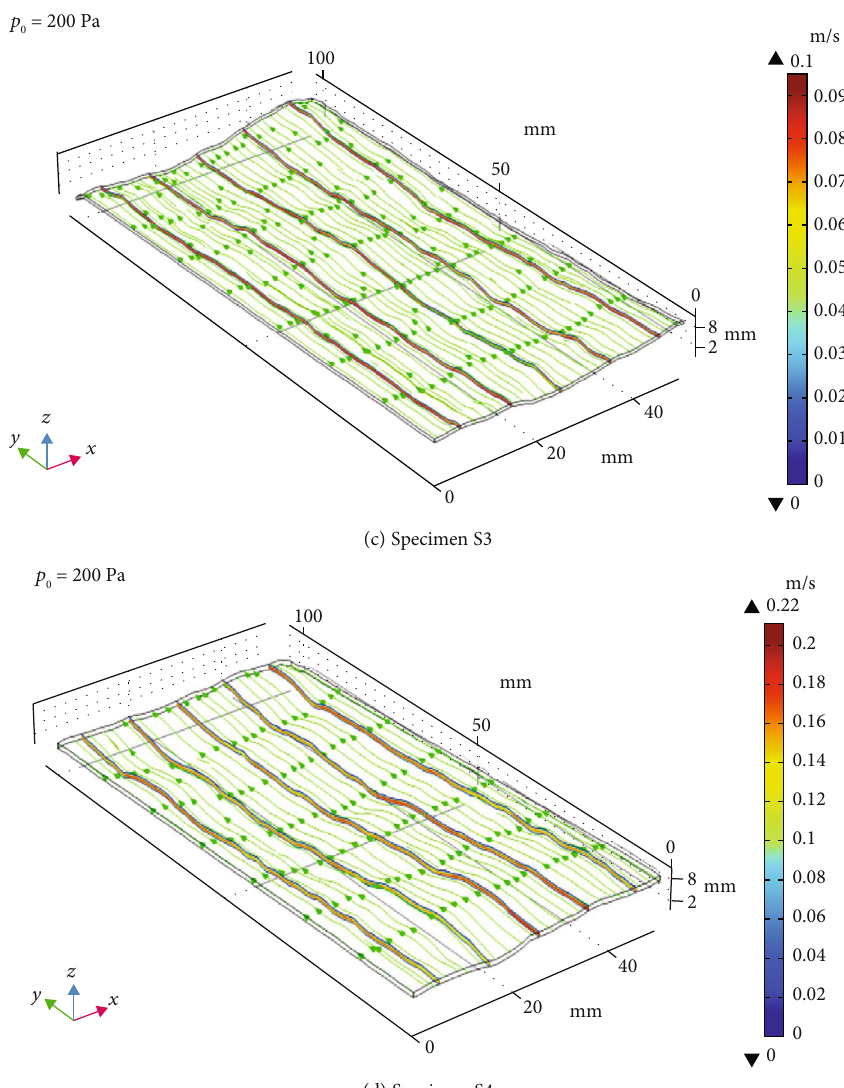
Figure 11: Velocity distribution on fracture surface of specimens